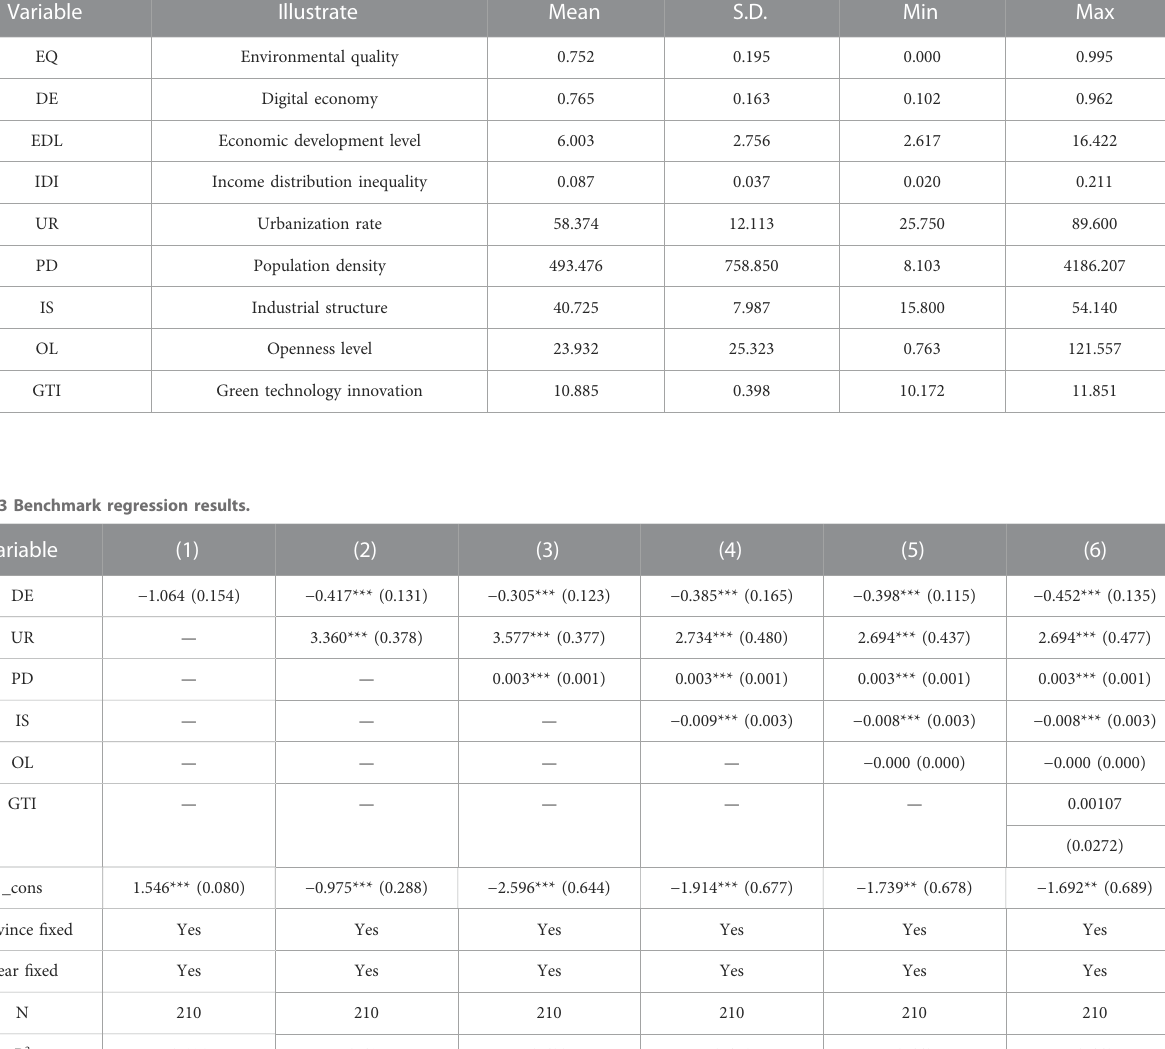
TABLE 2 Descriptive statistics for key variables. Variable